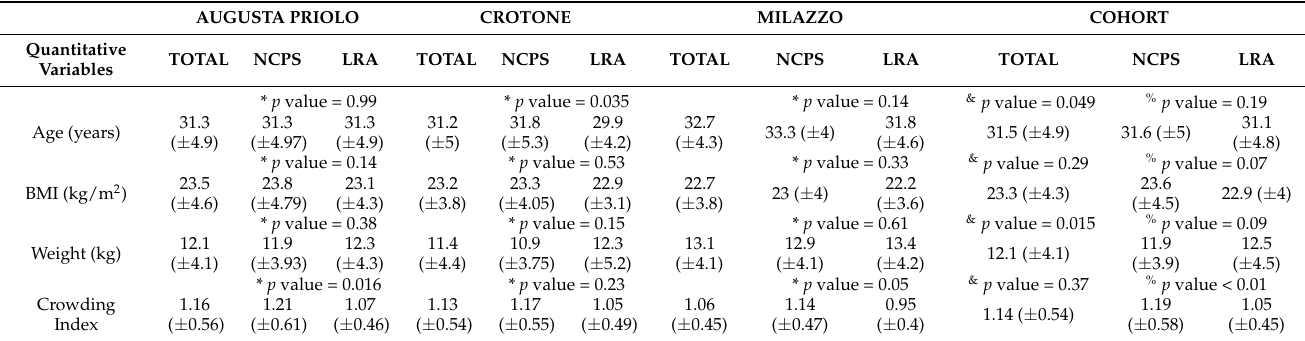
Table 1. Descriptive characteristics of participants to the Neonatal Environment and Health Outcomes birth cohort.